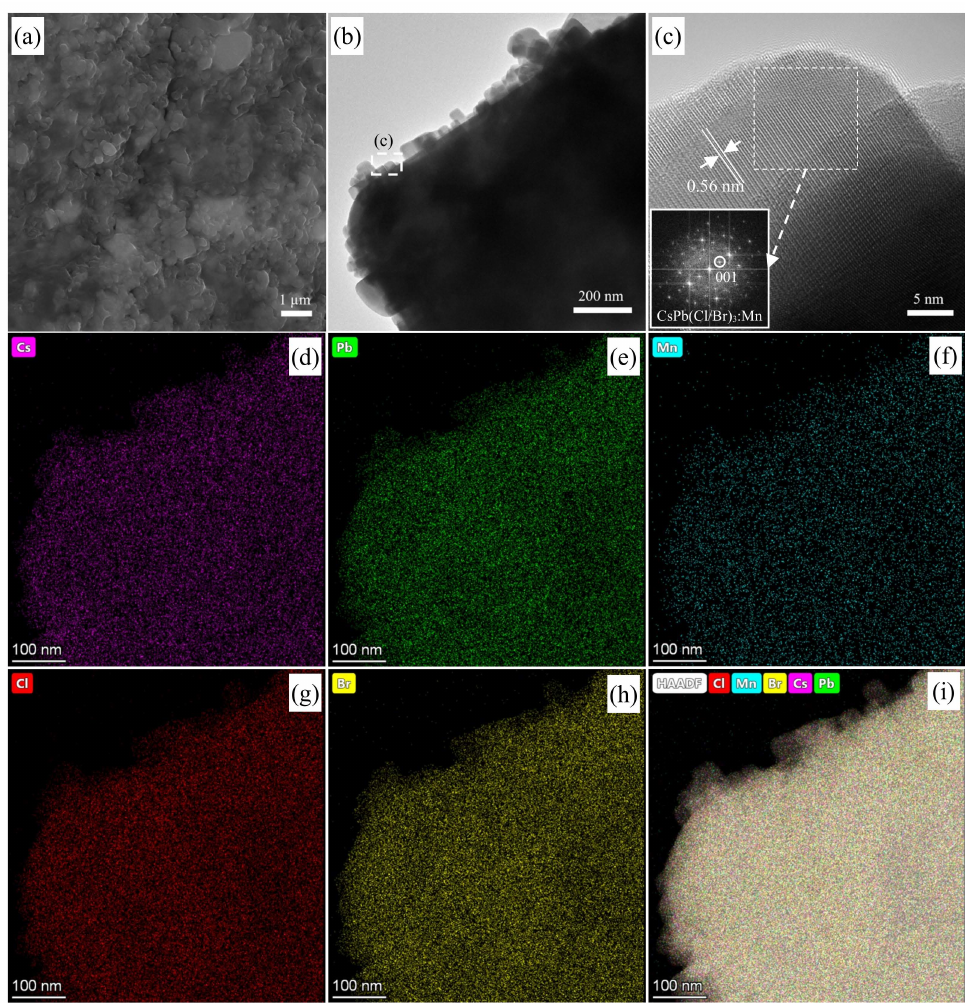
Figure 9. ( a ) SEM, ( b ) TEM and ( c ) HRTEM images of the optimum CsPb(Cl/Br) 3 :Mn product; inset: FFT pattern. The elemental maps of ( d ) Cs, ( e ) Pb, ( f ) Mn, ( g ) Cl, ( h ) Br, and ( i ) their overlay with the HAADF-STEM image of the optimum CsPb(Cl/Br) 3 :Mn